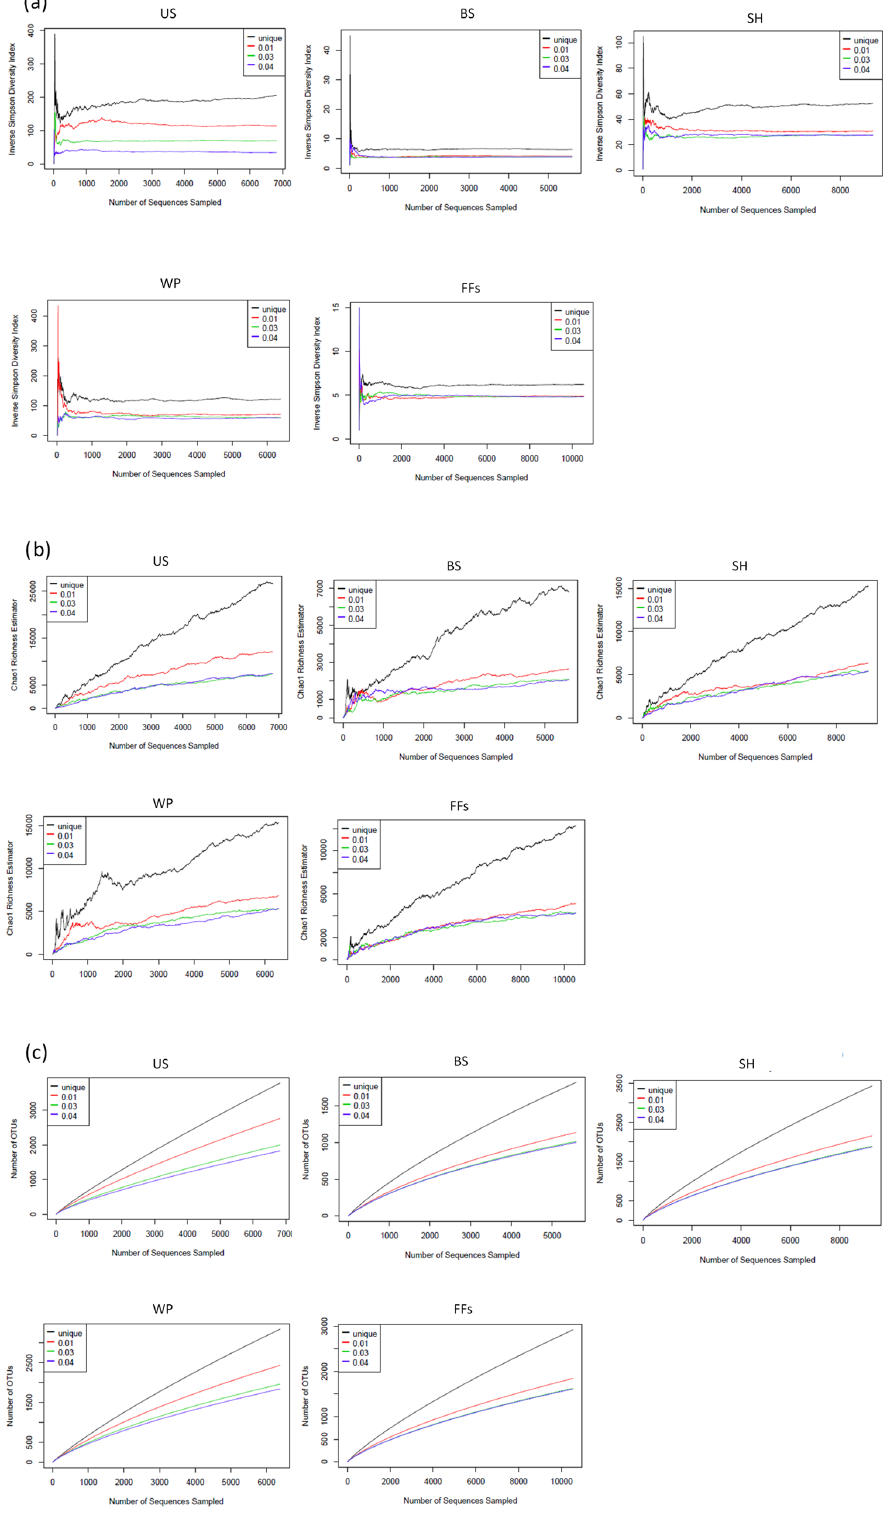
Figure A1. Bacterial diversity by 454 NGS analysis. The diversity of the bacterial communities for Arctic samples: blowing snow (BS), surface hoar snow (SH), windpack snow (WP), frost flowers (FFs); and urban snow (US) was estimated using the Inverse Simpson Diversity Index (a) , species richness using the nonparametric Chao index (b) , and Rarefaction Metric (number of OTUs) (c) with 3% cut-off value in sequence differences for